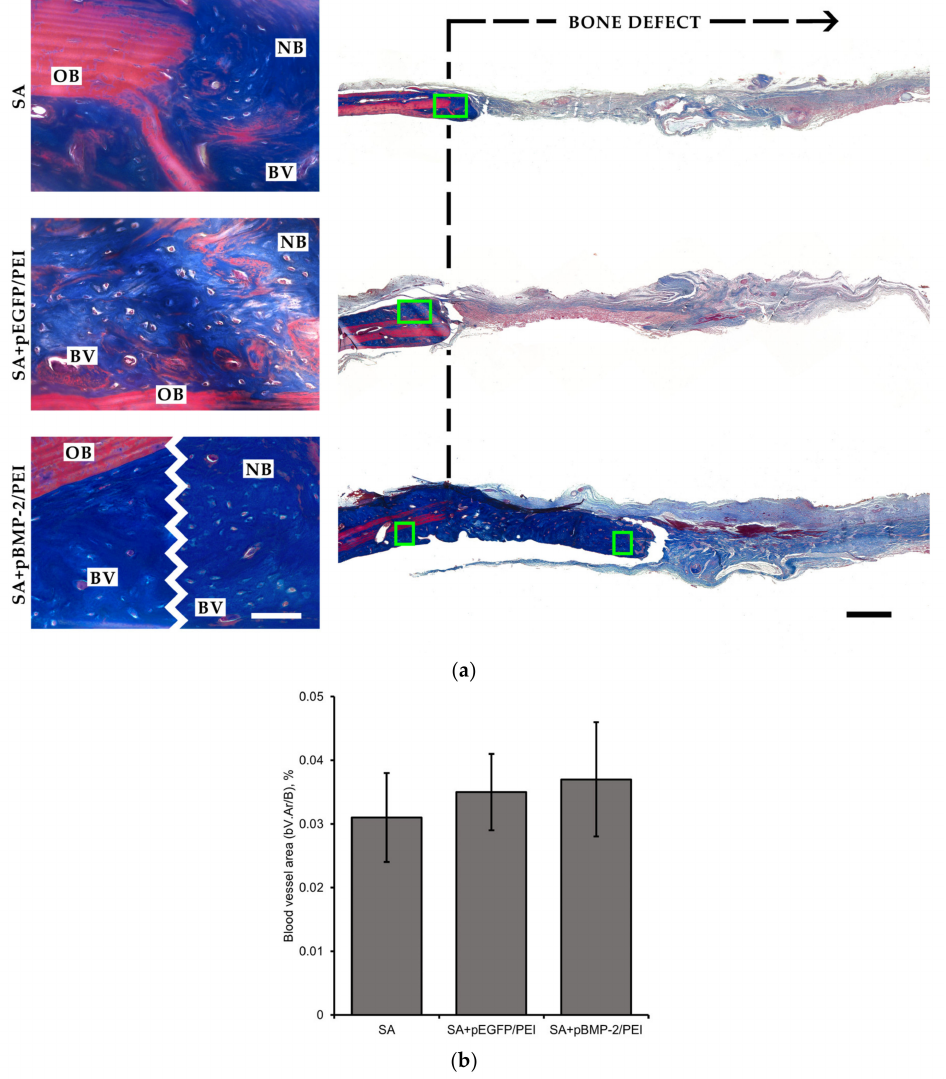
Figure 5. Bone regeneration in vivo. ( a ) Representative histologic sections at 8 weeks after implan- tation of SA scaffolds into a critical-sized cranial defect. New bone formation in the defects treated with scaffold only; GAS with pEGFP/PEI and GAS with pBMP-2/PEI. Masson’s trichrome staining. Light microscopy. OB—old bone. NB—new bone. BV—blood vessel. Scale bar 50 µ m ( left ) and 500 µ m ( right ). ( b ) Assessment of the blood vessel area in new bone